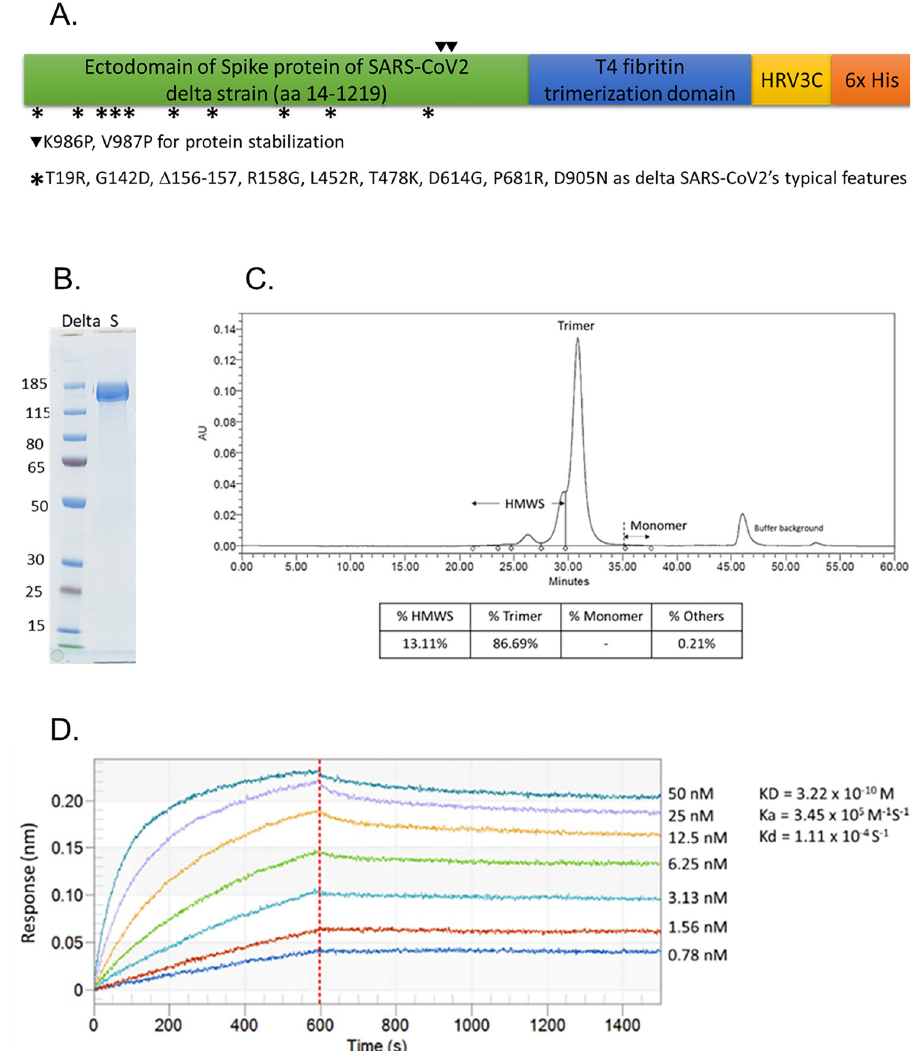
Fig 1. Characteristics of BCVax delta strain spike protein. (A) Linear diagram of the delta S protein sequence. The mutation sites of delta strain including T19R, G142D, Δ 156–157, R158G, L452R, T478K, D614G, P681R, and D950N were as indicated. (B) SDS-PAGE analysis with Instant Blue staining of delta-S protein under de-naturing conditions. (C) SEC-UV analysis of delta S protein after His-tag removal and purification. (D) Human ACE2 binding activity evaluation of delta S protein using ForteBio Octet analyzer. Data shown in colored lines representing different concentrations of S protein. KD values were calculated using a 1:1 global fit model (Octet). %HMWS: percentage of high molecular weight